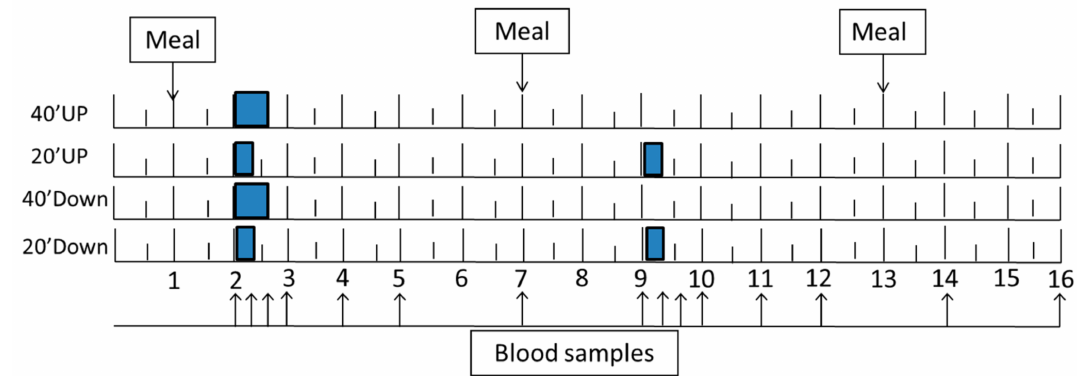
Figure 1. Experimental design. A single 40-min exercise bout, and the first of the two spaced 20-min exercise bouts, started at 08:00 h (point 2), while the second of the spaced bouts started 7 h later at 15:00 h (point 9). Of the three meals, the morning and mid-day meals were taken at 07:00 h (point 1) and 13:00 h (point 7), and the evening meal at 19:00 h (point 13). Arrows indicate times of blood